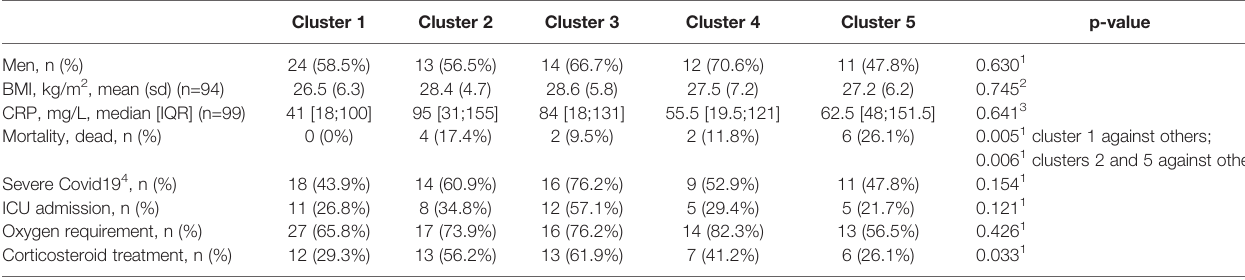
TABLE 5 | Overall comparison of clinical and biological characteristics between the clusters.